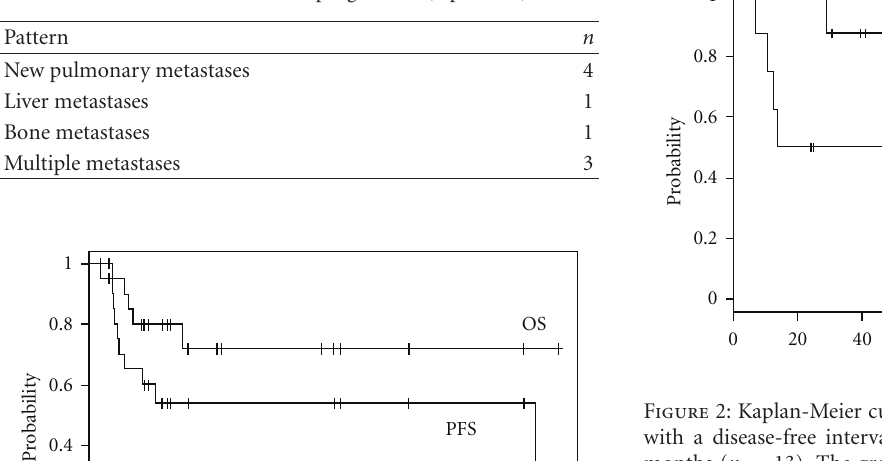
Table 2: Patterns of disease progression (9 patients).